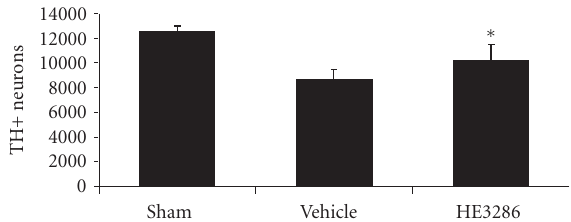
Figure 5: HE3286 attenuated TH-positive neuron loss in the SNpc. Mice (male, C57/Bl6, 8 per group) were given four injections of 20mg/kg MPTP 2h apart. HE3286 (40mg/kg), vehicle, or saline was administered by oral gave twice daily for four consecutive days beginning 1h after the last MPTP injection. Four days after MPTP injection, mice were sacrificed and brains collected. Coronal SNpc sections from four randomly selected animals per group were immunoreacted with anti-TH antibodies. TH positive neurons were determined on three serial sections per animal. ∗ Significantly greater compared to vehicle, P = 0.003; significantly lower compared to sham, P = 0.0024, by the Mann-Whitney exact